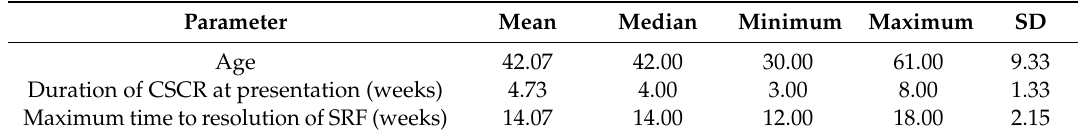
Table 1. Demographics of the study